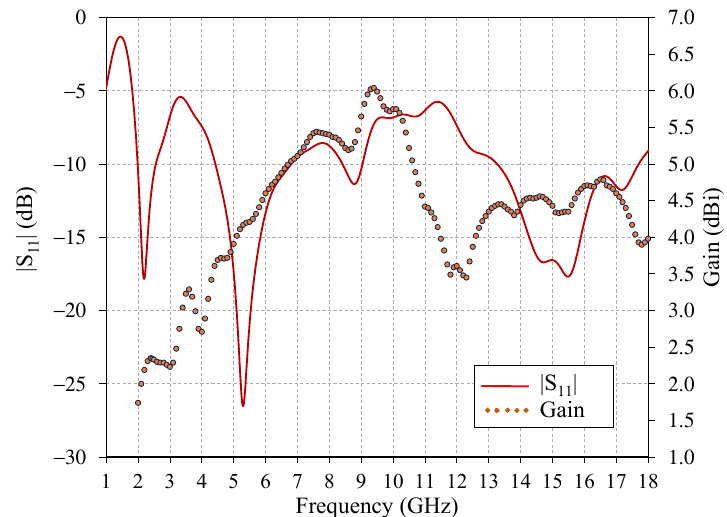
Figure 4. Simulated |S 11 | and gain of the proposed antenna.